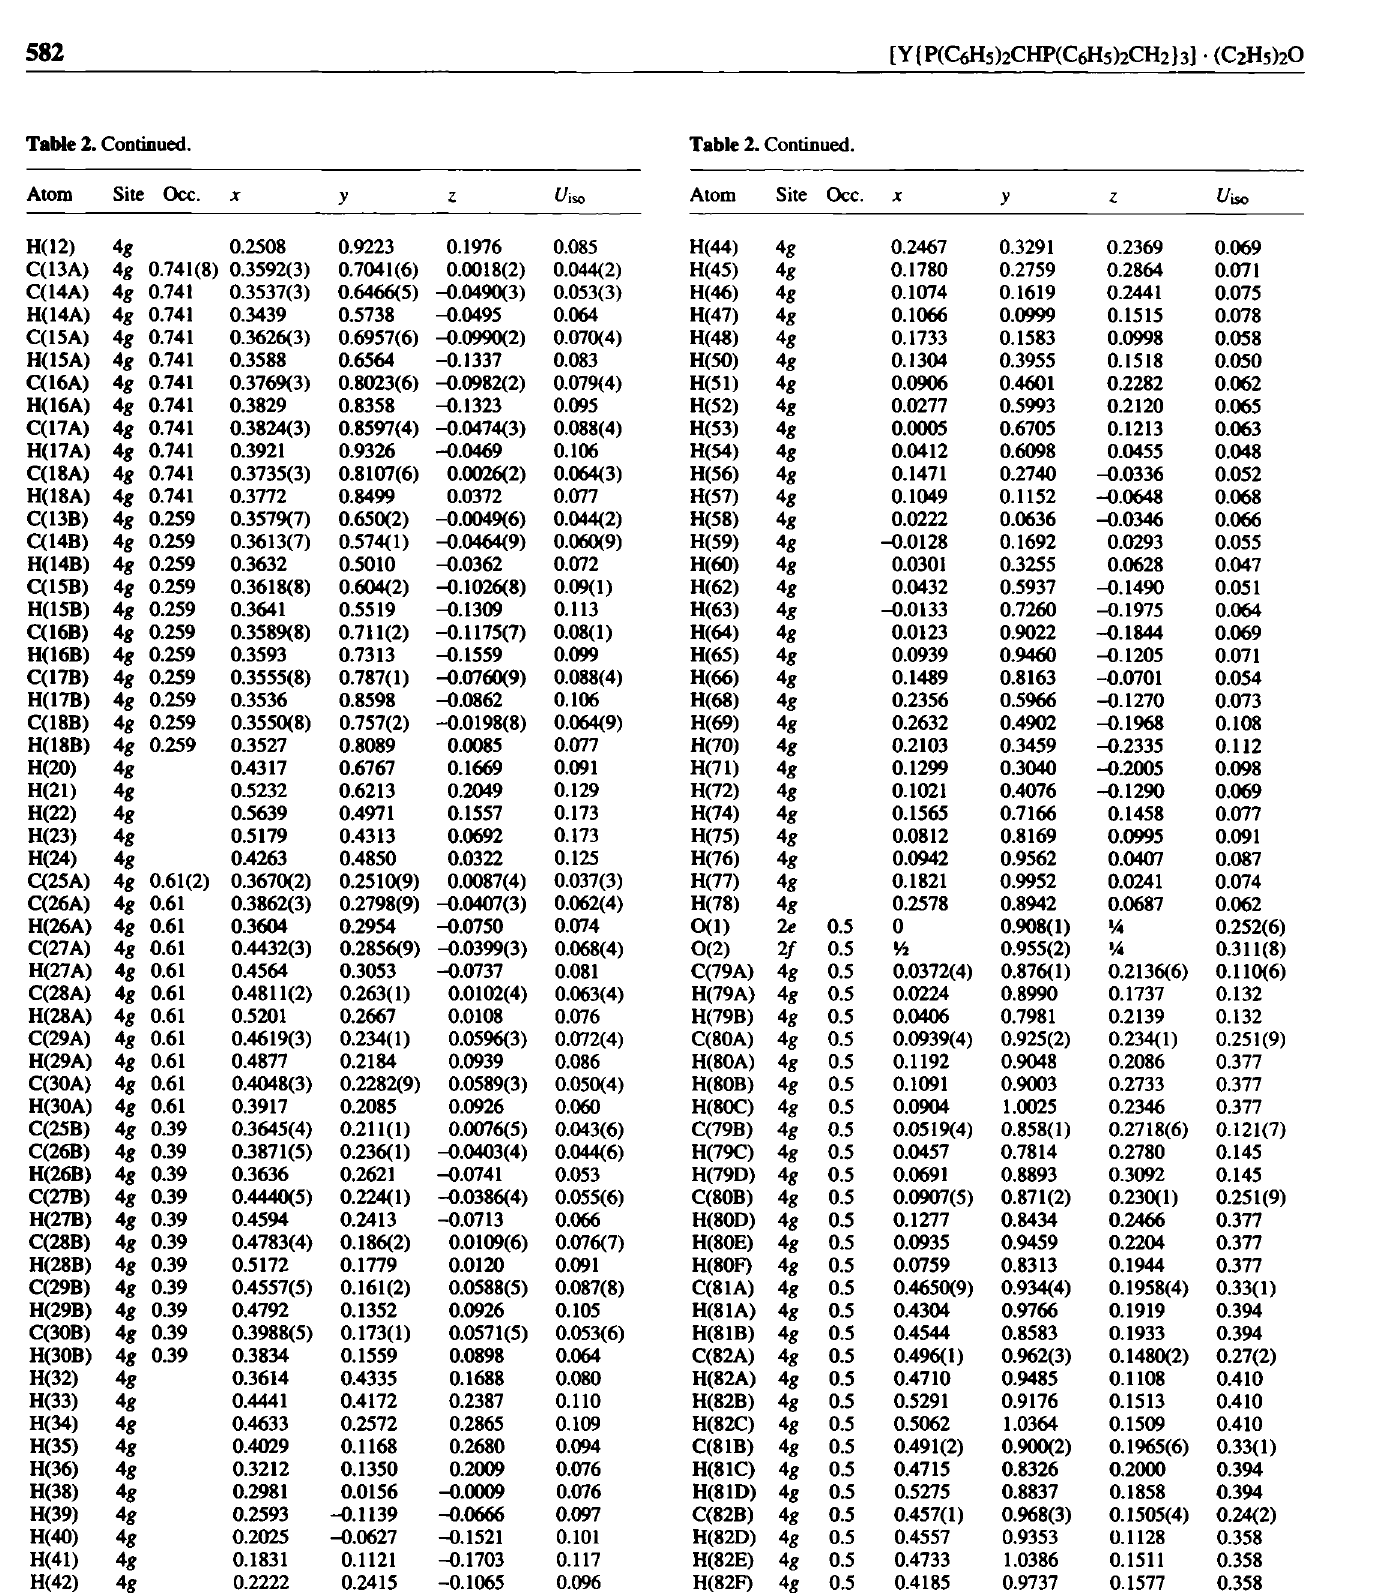
Table 3. Atomic coordinates and displacement parameters (in Ä 2